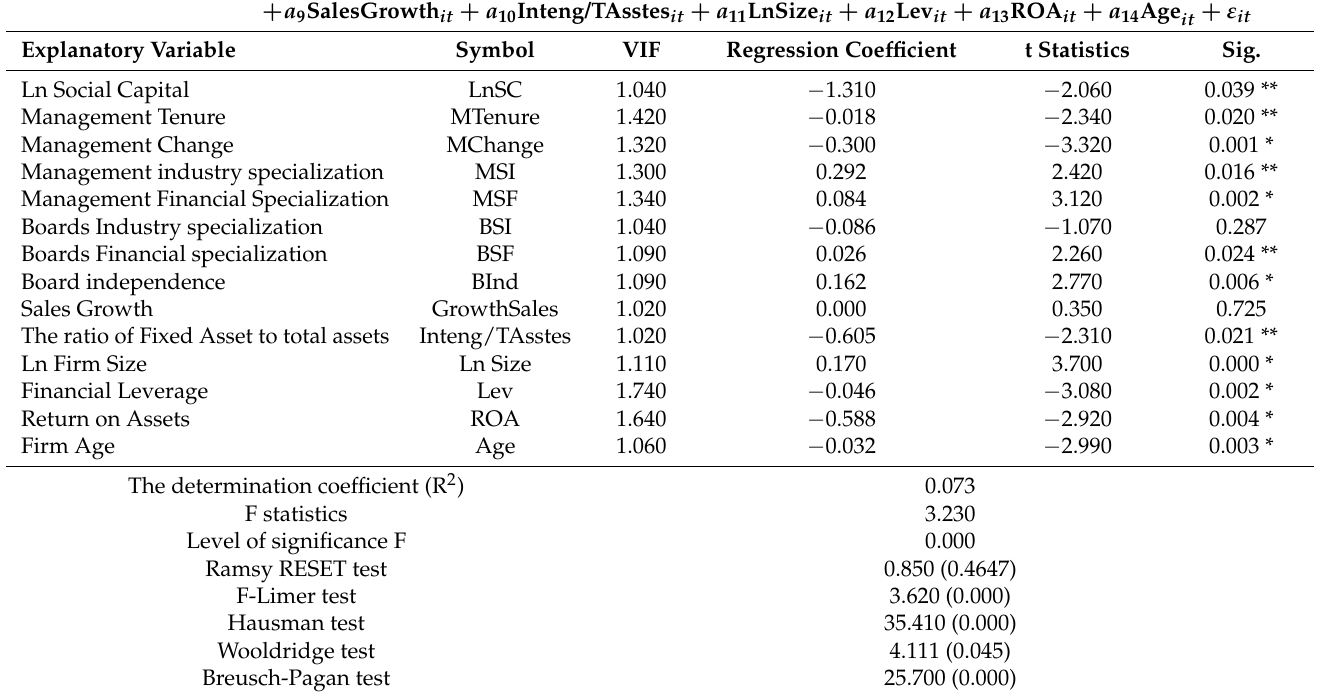
Table 5. The Results of testing the third hypothesis